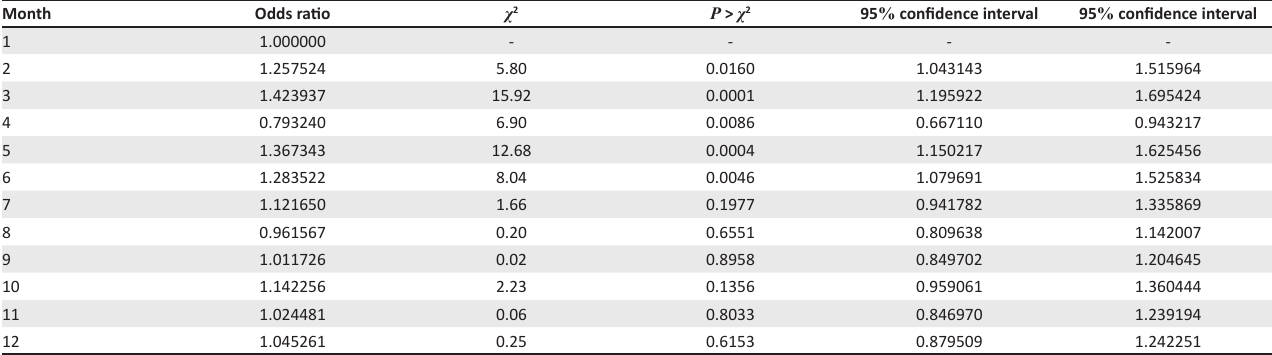
TABLE 3-A1: Case–control evaluation of monthly kid wastage using logistic regression